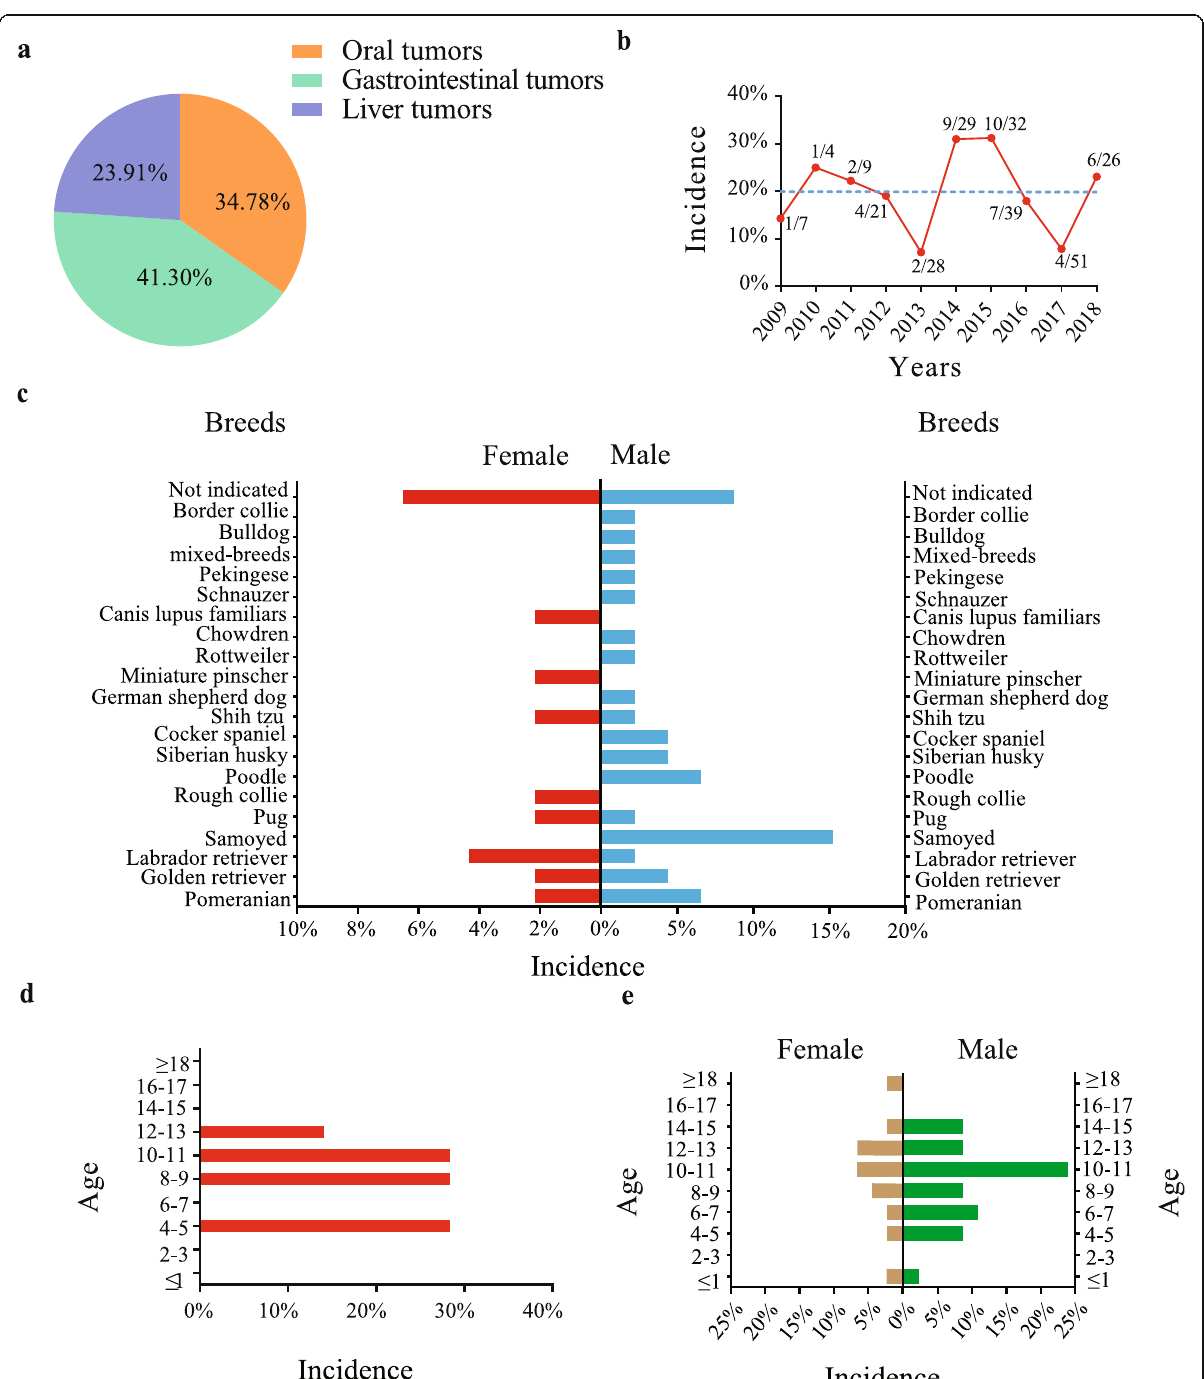
Fig. 4 Correlation of sex, age and breed with digestive tumors in pet dogs. a Proportion of different types of digestive tumors. b Dynamic changes of digestive tumors incidence in pet dogs from 2009 to 2018. The dotted line stands for linear regression. c Incidence of digestive tumors in different breeds of male and female pet dogs. d Incidence of digestive tumors in male Samoyed at different ages. e Incidence of digestive tumors in male and female pet dogs at different